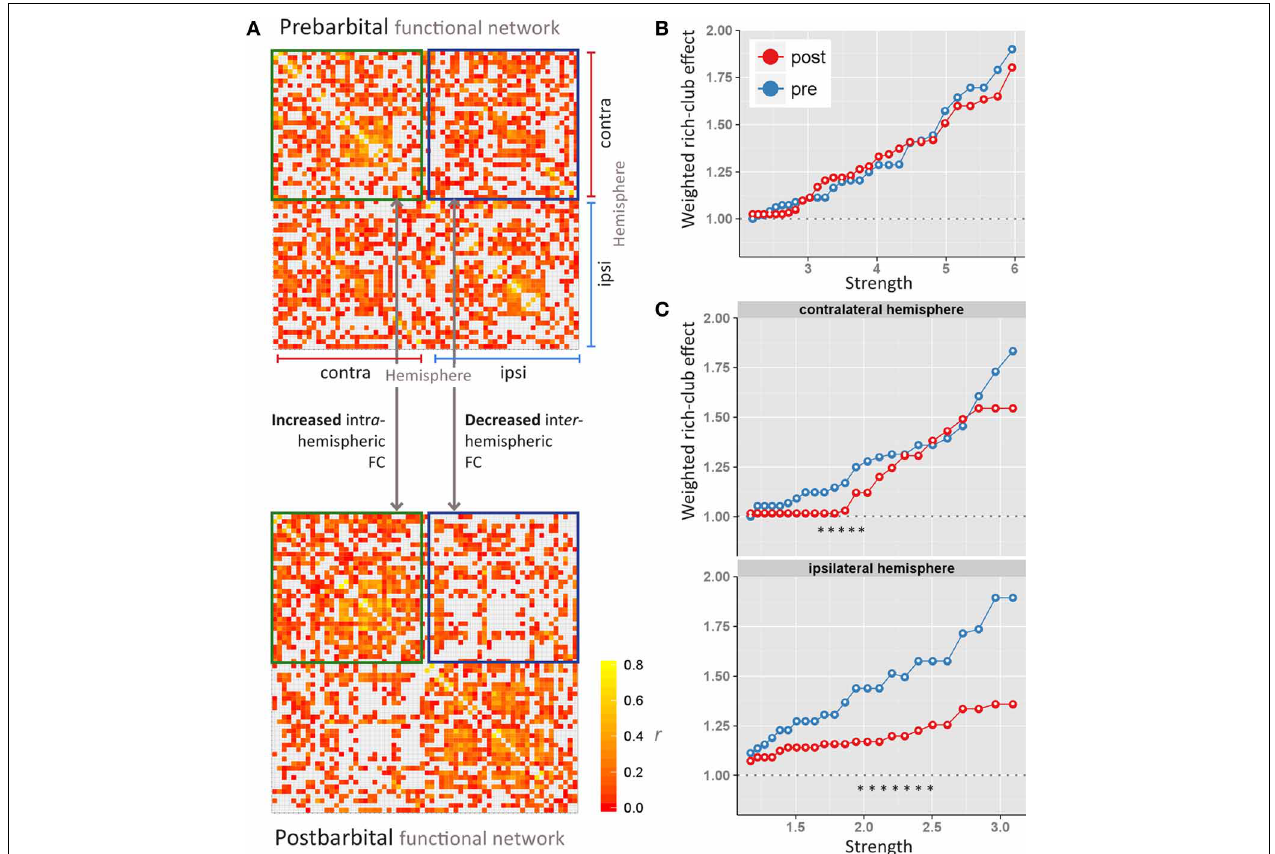
FIGURE 3 | Pre- and postbarbital (A) whole-brain functional connectivity (FC) networks, displayed as matrices. Each row and column stands for a region-of-interest in the hemisphere ipsi- or contralateral to the side of cannulation. Matrix elements are colored according to FCs values, measured as the correlation coefficient r between regions-of-interest. Red indicates no FC; yellow indicates high FC. Interhemispheric FCs are delineated with blue squares; intrahemispheric FCs with green squares. Weighted rich-club effects (y-axis) are plotted against increasing levels of strength (x-axis) for the